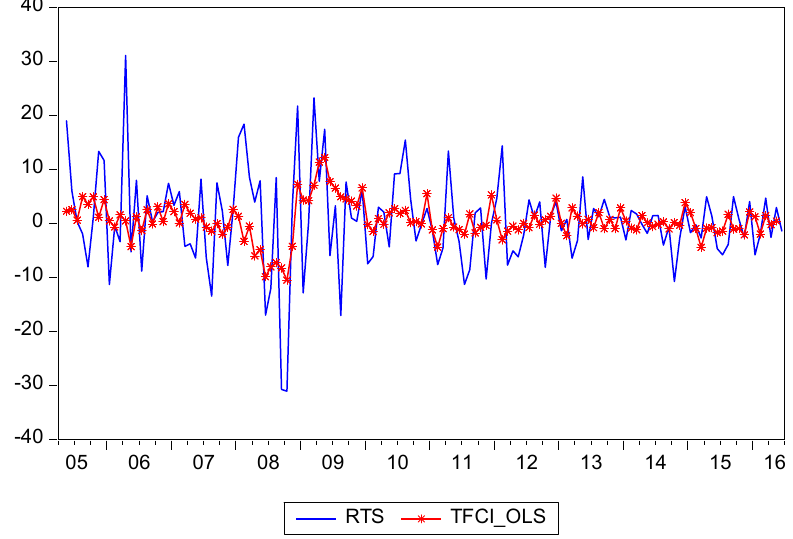
Figure 3. RTS and OLS estimates of TFCI for April 2005–June 2016.